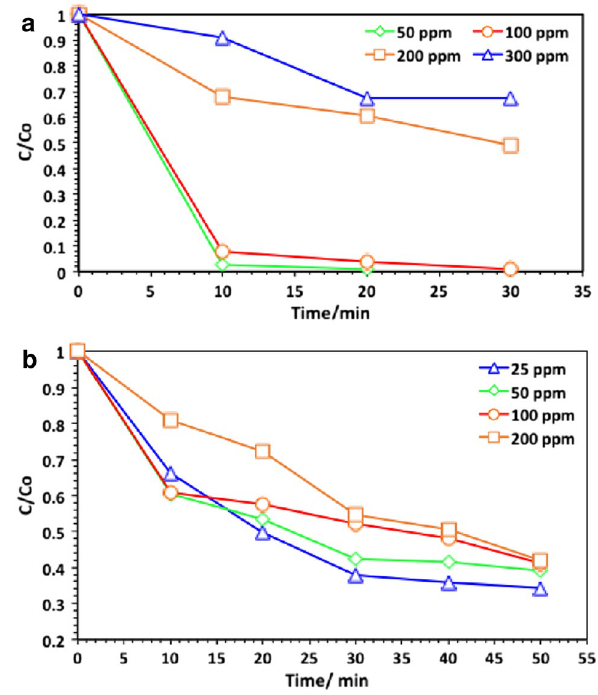
Fig. 7 Effect of different solution pH on a LFR (Dye H 2 O 2 800 mg/L; AS400 1.5 g/L) and b LA (Dye o 50 mg/L; H 2 O 2 200 mg/L; AS400 1 g/L) azo-dyes removal during oxidation for dif- ferent time ( t )